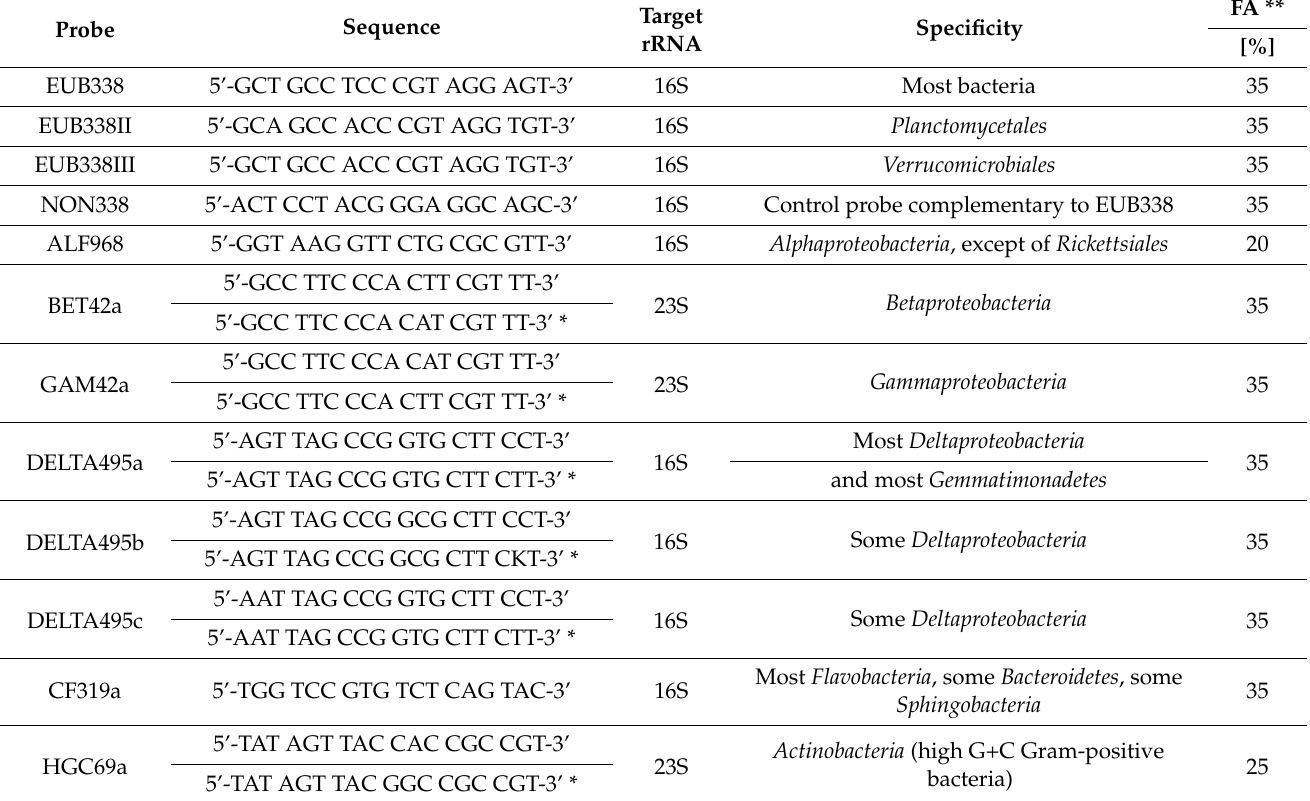
Table 2. Oligonucleotide probes used in the